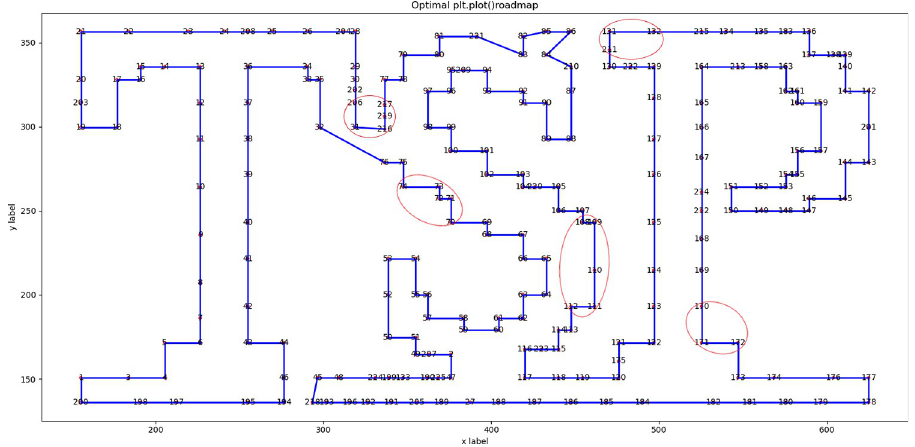
Fig 6. The optimal route of Tsp225 output by DSRABSQL